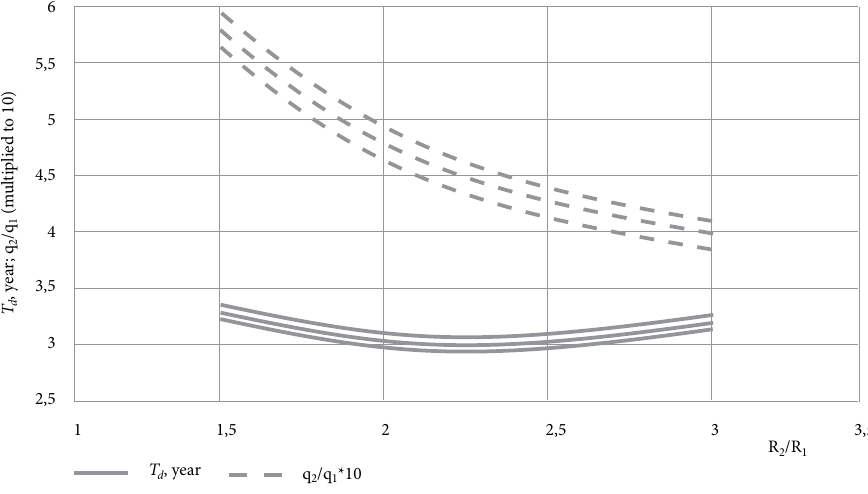
fig. 2. The same to Fig. 1, but for conditions of